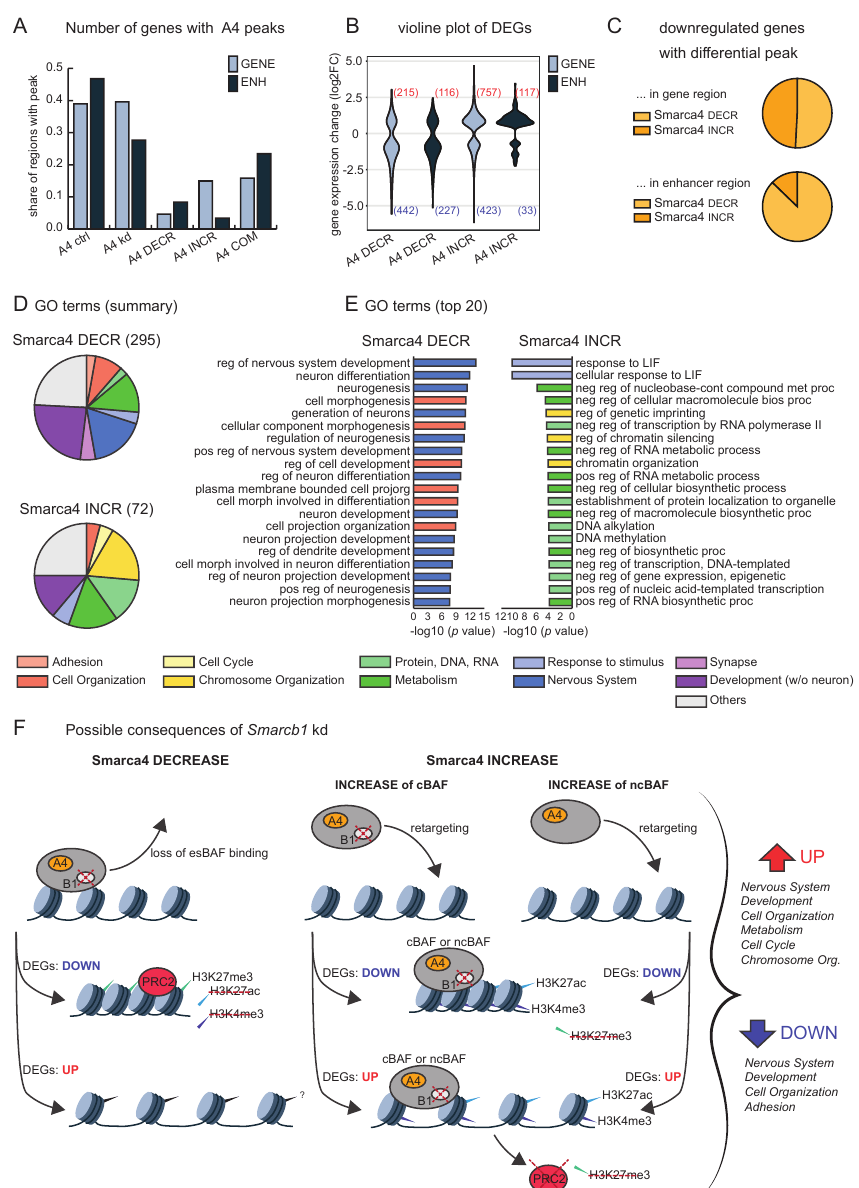
Figure 5. Smarcb1 knockdown impacts BAF complex binding in enhancer regions ( A ) Comparison of Smarca4 binding of regions defined either as gene regions (1 kbp upstream of TSS to TES) or as enhancer regions (as defined by Shen et al. [68]). ( B ) Correlation of enhancer regions to the nearest gene (max. distance of 100,000 bp). Gene expression of those genes that were significantly deregulated ( p < 0.05, abs. log2FC > 0.58) are displayed in violine plots and their number is given in parenthesis. ( C ) Pie charts displaying the amount of genes with Smarca4 DECREASE or INCREASE relative to all downregulated genes with a change in Smarca4 binding. ( D , E ) Biological process related GO terms that were assigned to genes with differential Smarca4 binding in their enhancer region. Genes with Smarca4 DECREASE or INCREASE were analysed separately using ToppGene and terms were separated into categories (as used for other GO-term analyses). Pie charts give a summary of these categories, bar charts only include GO terms within the top 20 (ranked by p value). In parenthesis, total numbers of GO terms are given. ( F ) Summary of possible consequences of Smarcb1 kd for BAF-complex function. In part, mechanisms by which changes in gene expression occur remain unclear (especially concerning upregulated genes with Smarca4 DECREASE and downregulated genes with Smarca4 INCREASE without Ezh2